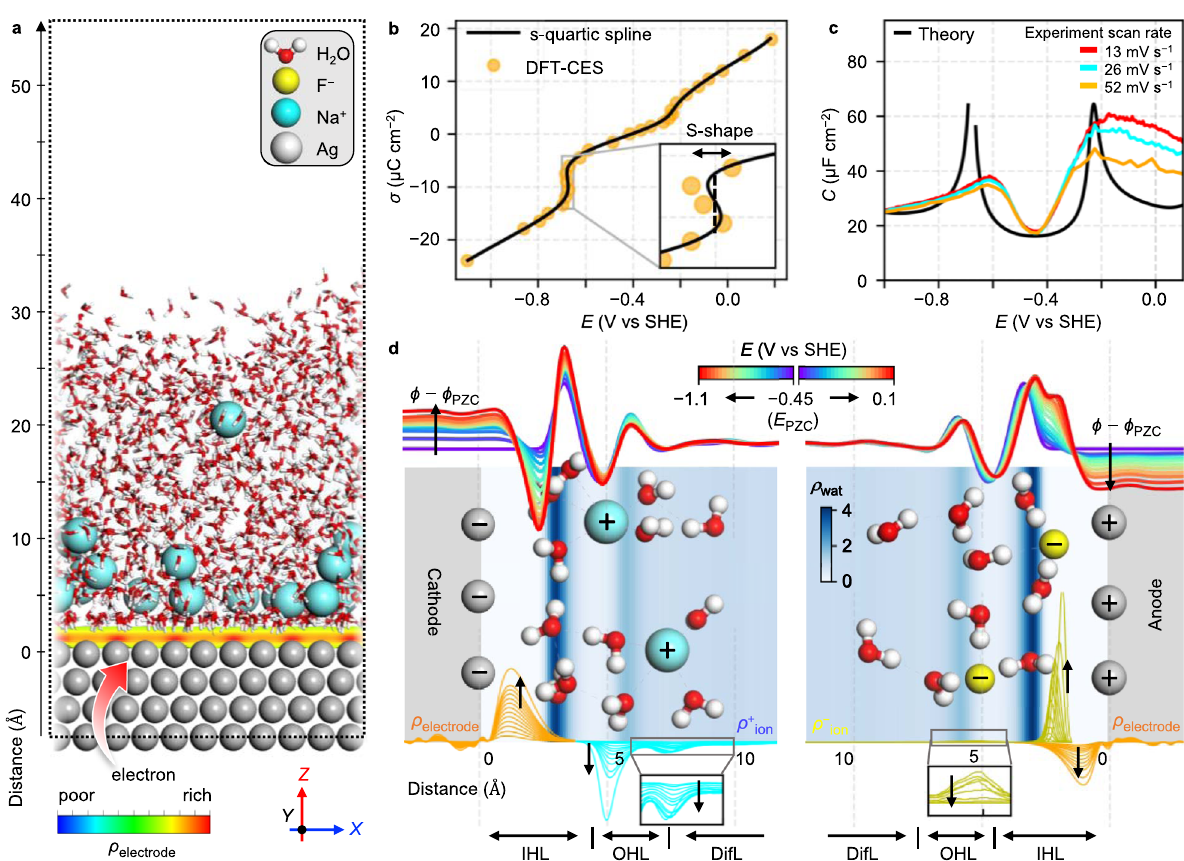
Fig. 1 Molecular simulation of EDL charging curves and local pro fi les of constituents. a A snapshot of the simulation system consisting of an Ag(111) electrode-electrolyte-vacuum interface. The excess charge density of the metal electrode, ρ electrode , is shown as a color map that is screened by either excess Na + or F − ions in the electrolyte. b Surface charge density, σ , calculated as a function of the electrode potential, E (vs standard hydrogen electrode (SHE)). A dashed vertical line is constructed along the coexisting line of two different charge states. The black solid line is smoothed quartic (s-quartic) spline fi tting function of the DFT-CES data. c Comparison between the camel-shaped curve of the differential capacitance, C , versus E with that of the experiments on Ag(111) electrode in a 3 mM NaF electrolyte. d Representative structures of hydrated ions near the electrodes. Local density pro fi les of water, ρ wat , are shown as color maps in the background (unit: g cm − 3 ) that de fi ne the location of the IHL, OHL, and DifL. ρ electrode , and the ion charge density pro fi les, ρ ion , are also shown in the below row. Local electrostatic potential pro fi les, ϕ , are shown in the upper row, as a function of E . The black arrows indicate the increase in negative or positive charging from the PZC. Source data are provided as a Source Data fi